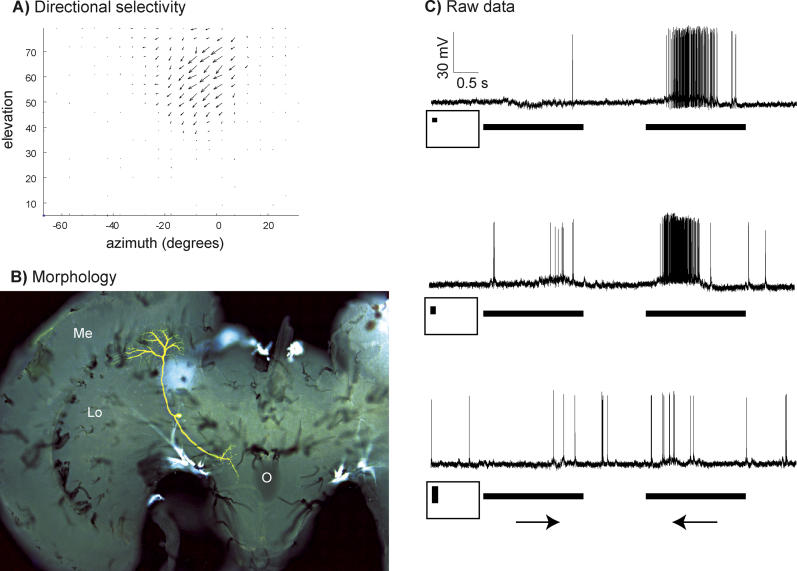
Physiology and Morphology of a Direction-Selective STMD Neuron Class Selected for Detailed Analysis (STMD 2)(A) A receptive field map of local preferred direction. The neuron responds optimally to motion down and away from the midline. The length of the arrows indicates the strength of the response, and its angle the preferred direction of motion (seeMaterials and Methods).(B) Az-axis projection of the morphology of STMD 2 after Lucifer yellow staining. A compact group of dendrites in the dorsal lobula plate correspond closely to the retinotopic location of the physiological receptive field and are presumably inputs. Outputs are located in the lateral subesophageal ganglion.Lo, lobula; Me, medulla; O, esophageal foramen.(C) Raw responses to target stimuli drifted against bright backgrounds as inFigure 1.